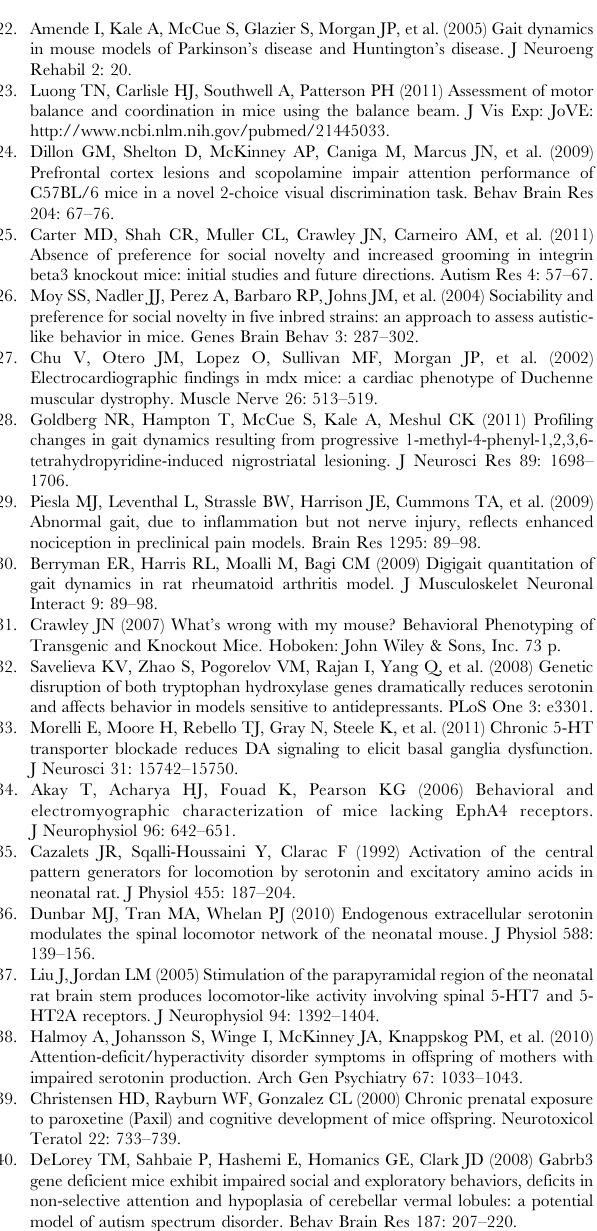
Figure S1 Tph1 ( 2 / 2 ) mice had normal fasting blood glucose levels (A, B), heart rate (C) and QRS interval duration (D).